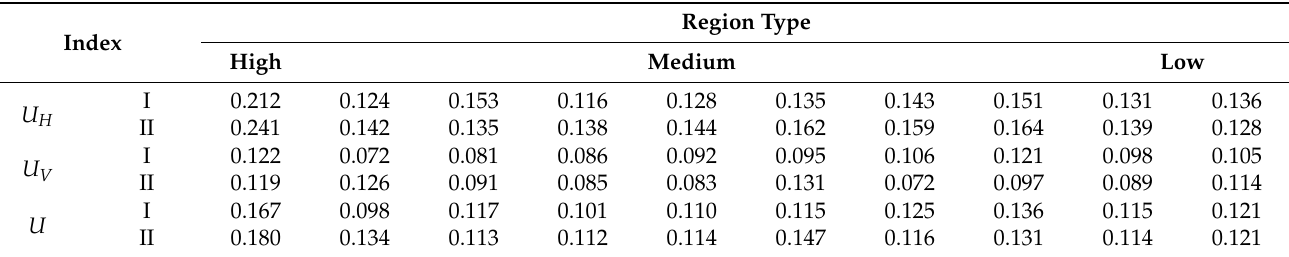
Table 5. Component homogeneity index of representative core samples in detection